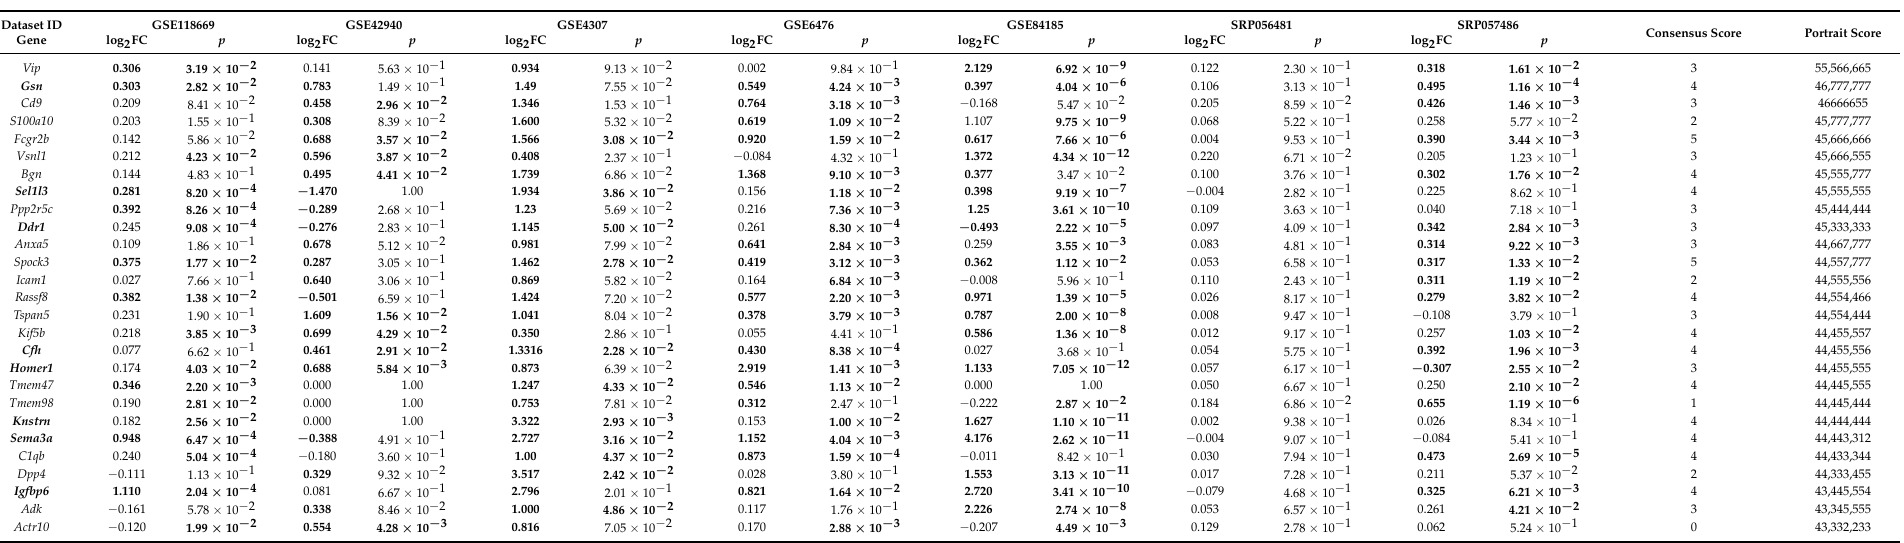
Table 7. Signature of FLX effect in naïve animals (portrait score